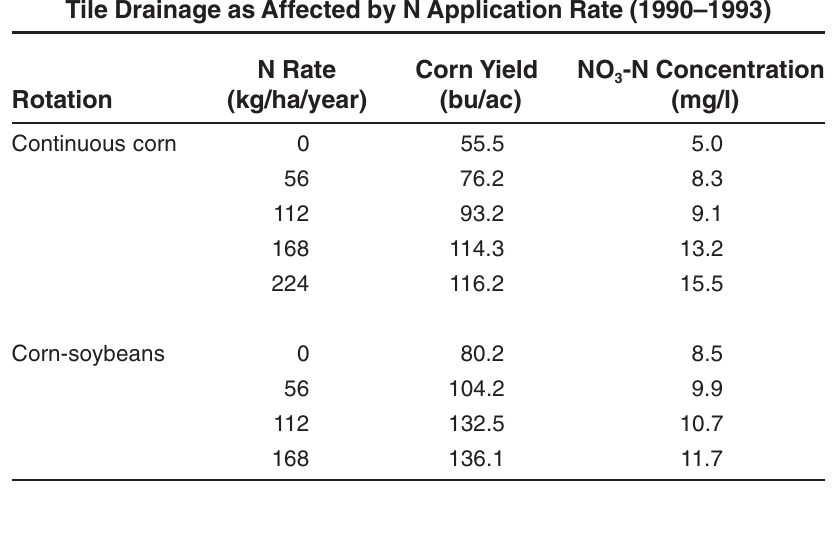
Corn Yields and NO